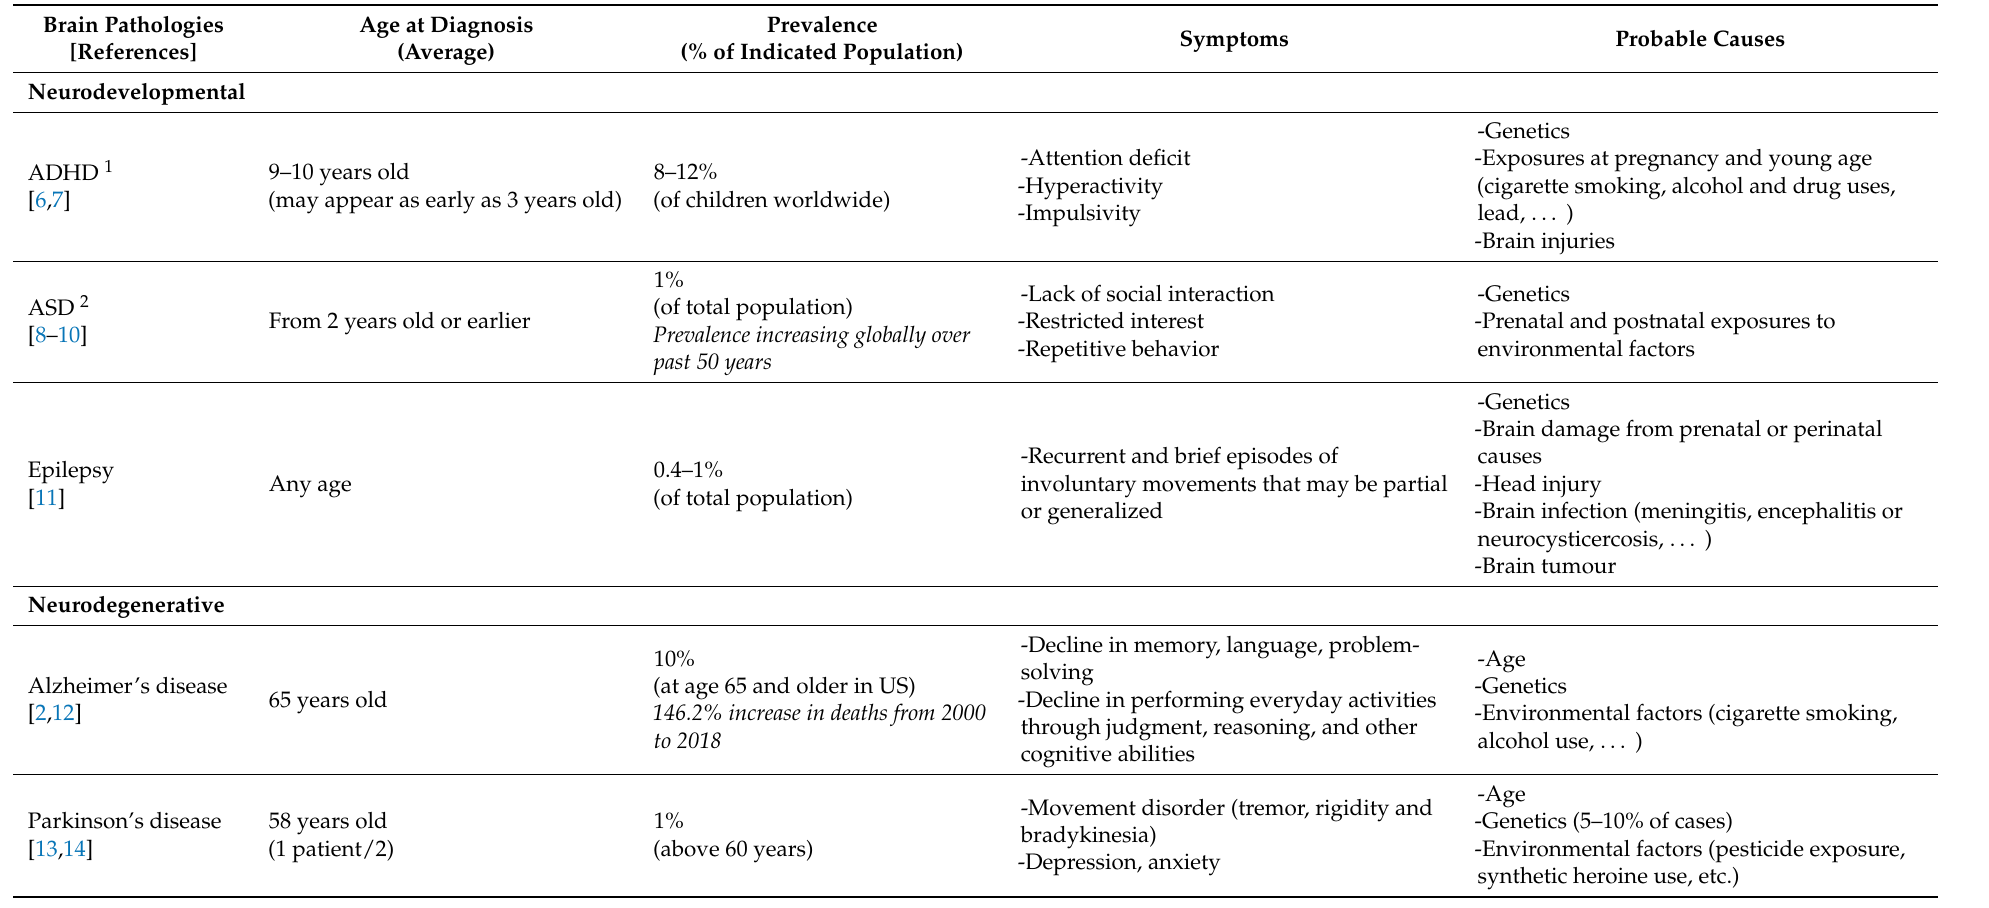
Table 1. Categories, diagnosis, prevalence, symptoms and causes of brain pathologies discussed in this